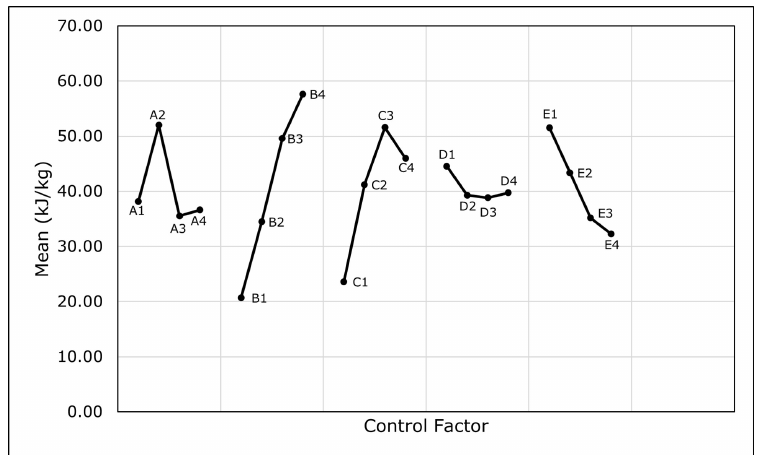
Figure 7. Response Chart: